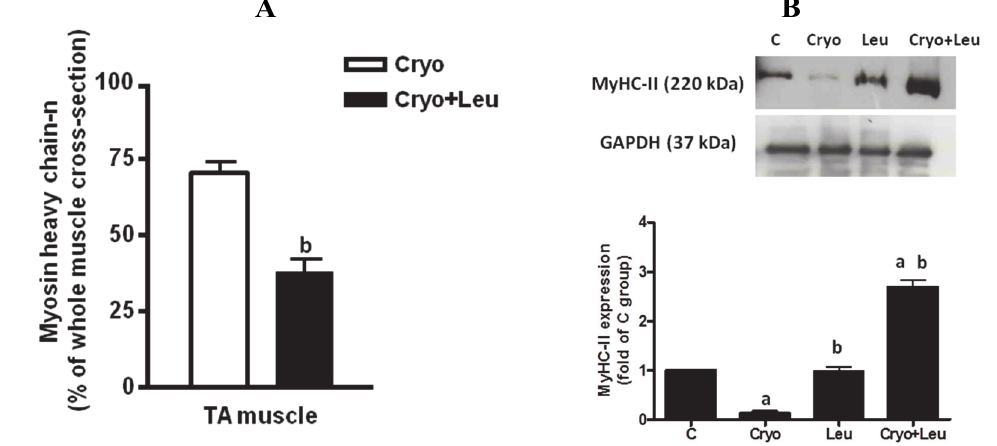
Figure 3. Number of MyHC- n -positive regenerating myofibers in TA muscles analyzed on Day 10 post-cryolesion (percentage of whole muscle cross-sectional area; ( A )). Representative western blots and densitometry analyses of MyHC-II from TA muscles at 10 days post-cryolesion ( B ). Muscle groups are identified at the top. C, control muscles; Cryo, muscles analyzed on Day 10 post-cryolesion; Leu, muscles after 13 days of leucine supplementation; Cryo + Leu, leucine supplemented group analyzed on Day 10 post-cryolesion. GAPDH was used as the standard. Data are expressed as the fold of MyHC-II expression detected in the C group. Molecular weight is presented in